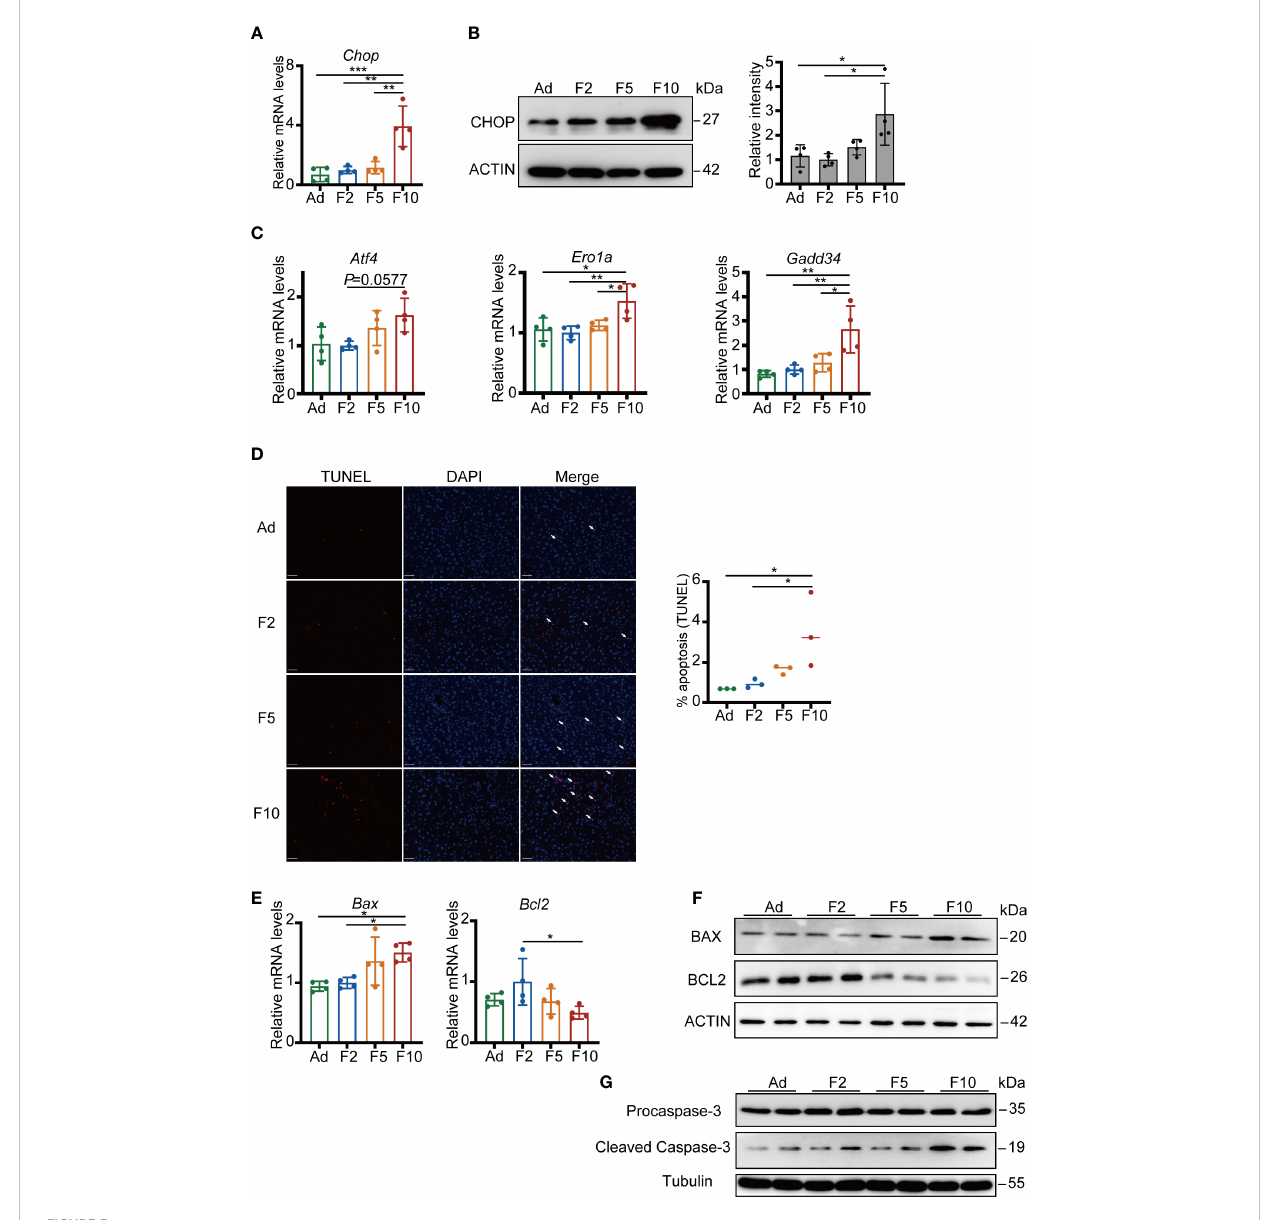
FIGURE 5 Multigenerational DRF increases ER stress-induced hepatocyte apoptosis. (A) Relative mRNA levels of Chop (n = 4). (B) CHOP protein levels (one representative fi gure is shown) and quanti fi cation of CHOP/ACTIN protein levels (n = 4). (C) Relative mRNA levels of Atf4 , Ero1a and Gadd34 (n = 4). (D) Representative TUNEL staining (red) of mouse liver. Nuclei were stained with DAPI (blue); scale bar, 50 m m. Quanti fi cation of the percentage of TUNEL-positive cells (n = 3). (E) Relative mRNA levels of Bax and Bcl2 (n = 4). (F) Protein levels of BAX and BCL2. (G) Protein levels of Procaspase-3 and Cleaved Caspase-3. All signi fi cance was calculated by one-way ANOVA. * P < 0.05; ** P < 0.01; *** P < 0.001 were considered signi fi cant. Error bars represent the mean ±